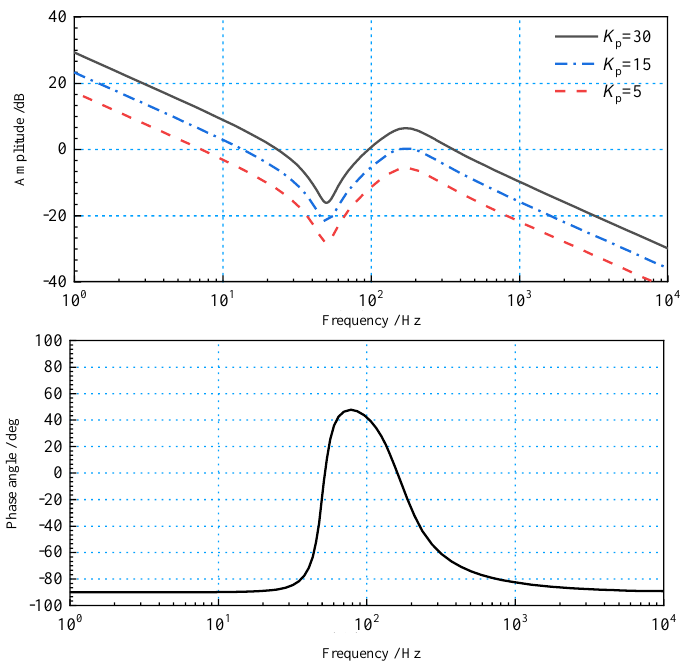
Figure 17. Open-loop Bode diagram under different open-loop gains.